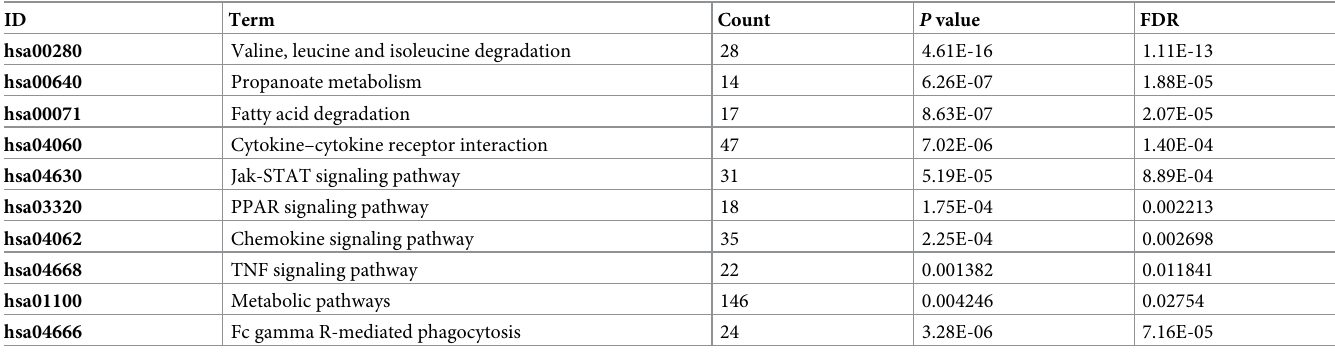
Table 2. Results of KEGG analysis of PLAUR coexpressed genes.